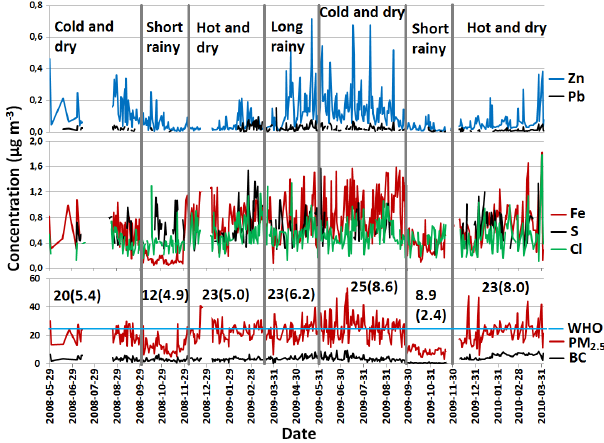
Figure 4. Seasonal variation of PM 2 . 5 and some elements sampled at the university site. Included in the figure are the seasonal aver- ages and standard deviations (enclosed in parentheses) as well as the World Health Organization air quality guideline for a 24h pe- riod.